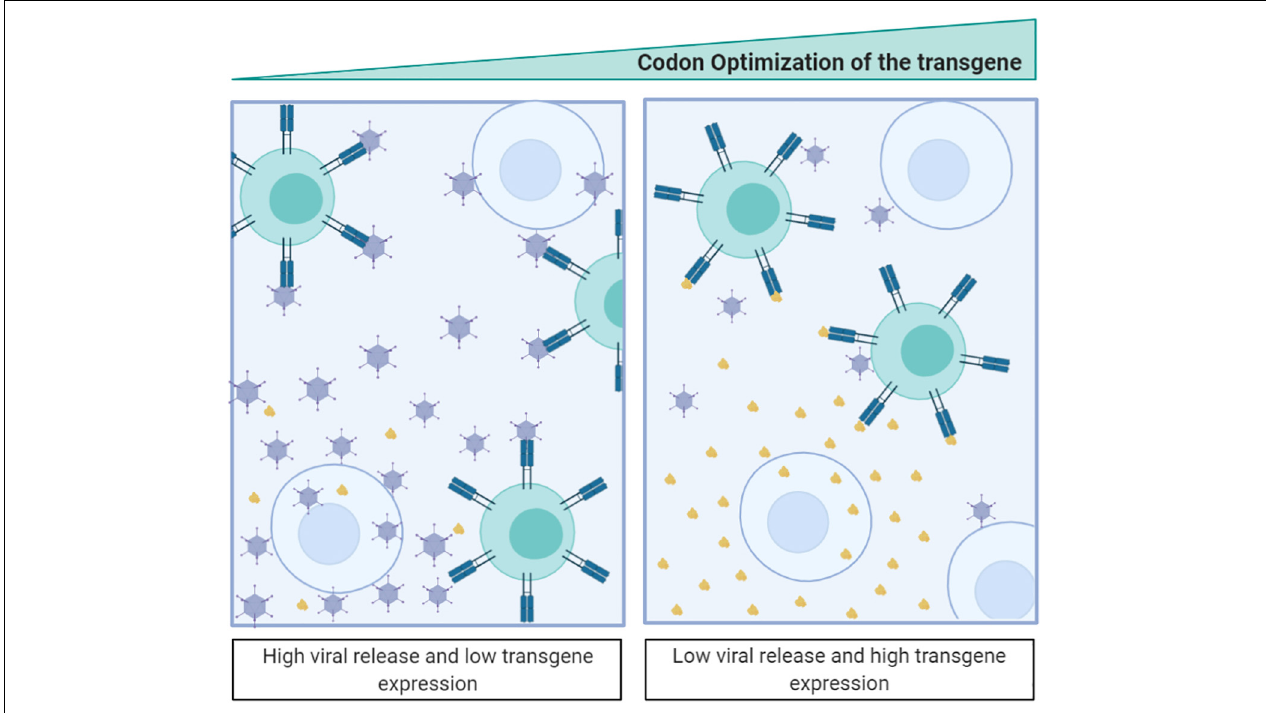
FIGURE 4 | Antigen-transgene recoding strategy for adenoviral-based vaccines. The scheme illustrates that codon optimization of the transgenic antigen induces its high expression while attenuates adenovirus fitness. Antigen expressed from the adenovirus is shown in brown.